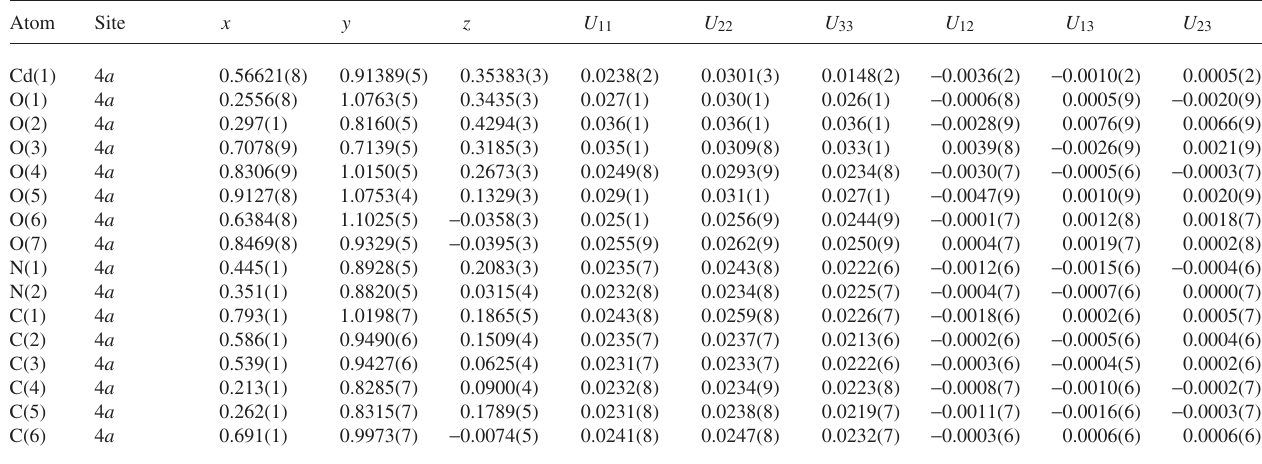
Table 3. Atomic coordinates and displacement parameters (in Å 2 ) .